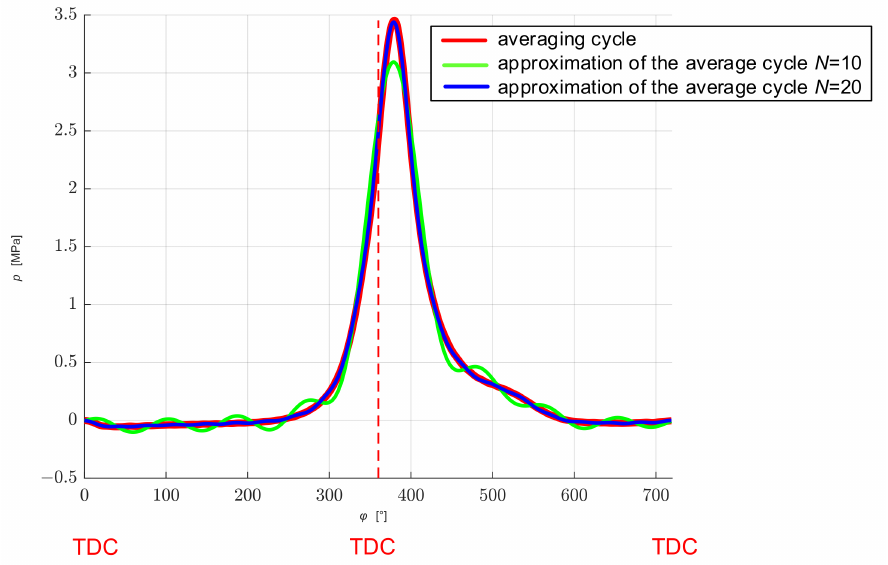
Figure 7. Comparison of the averaged discrete waveform with functions determined by a Fourier series with averaged coefficients for the number of components N = 10 and N =